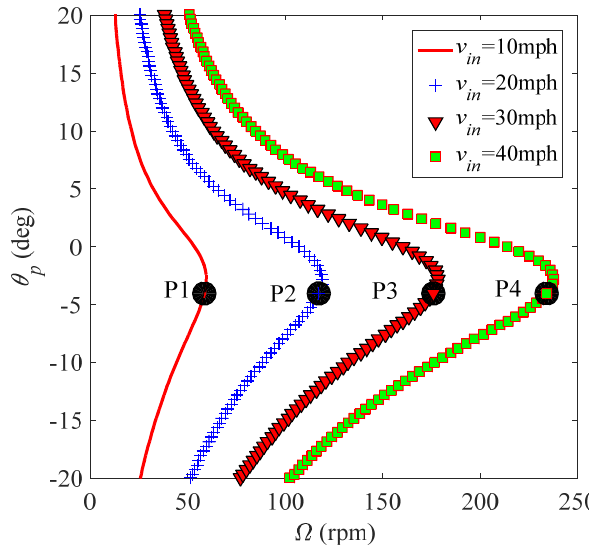
Figure 14. Optimal curve of the power coefficient C p max at different wind speeds.